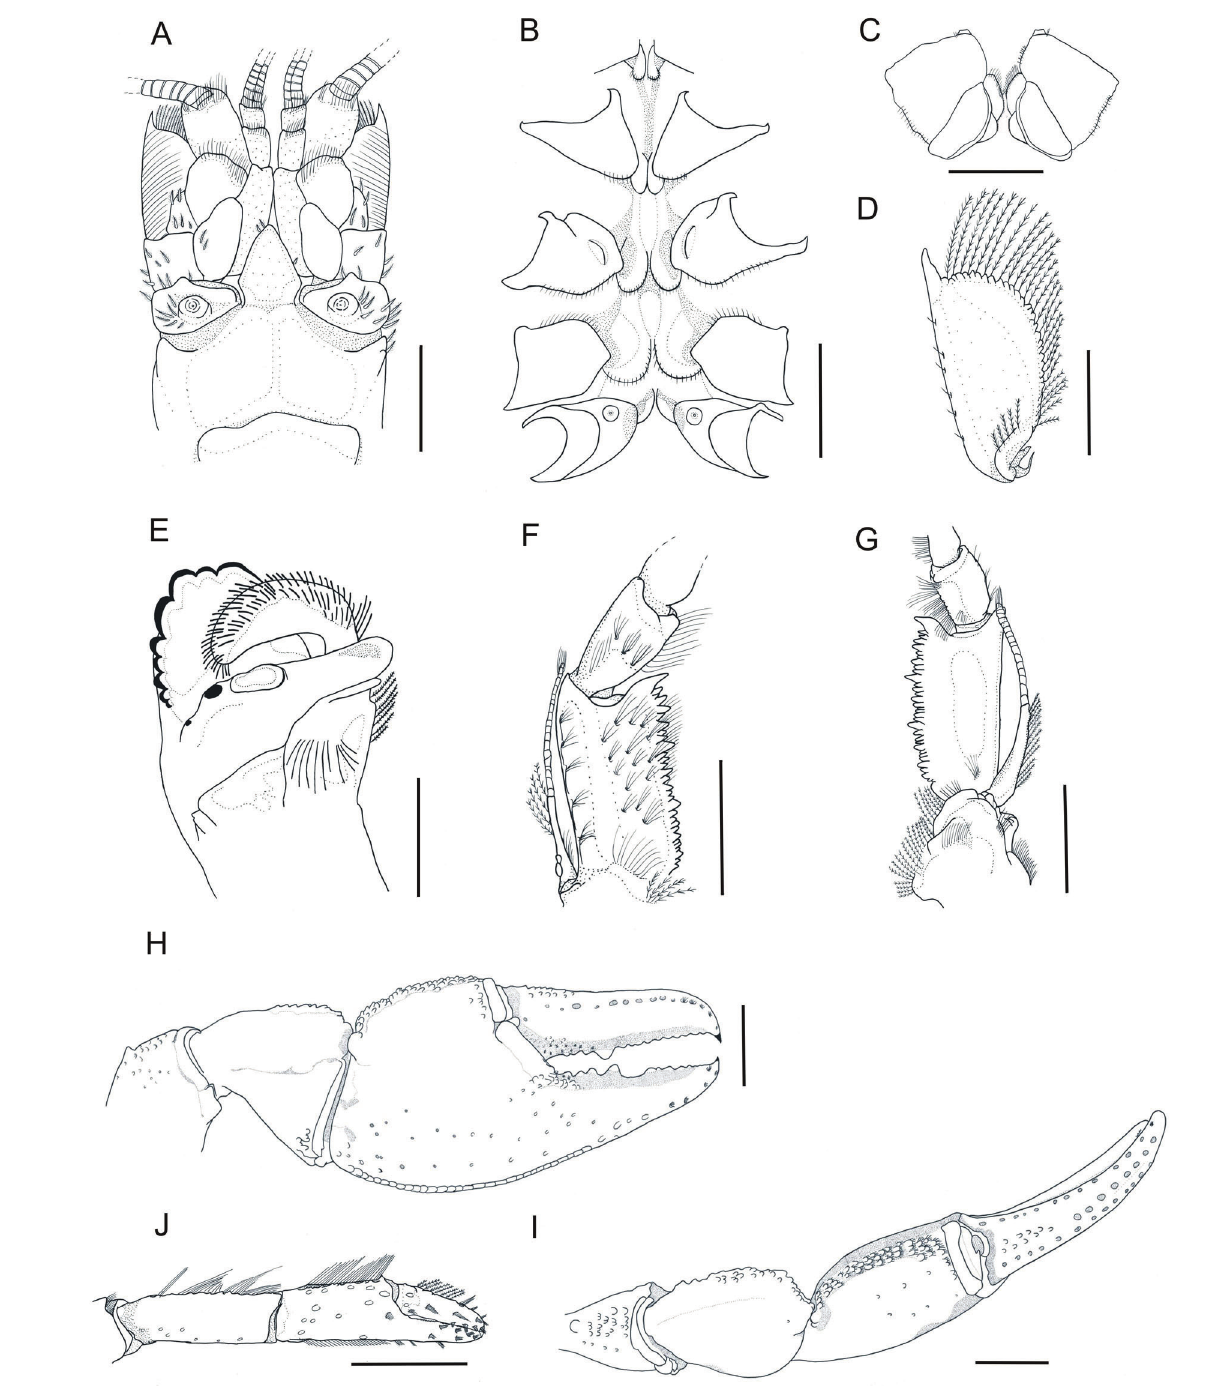
Figure 2. Parastacus tuerkayi sp. nov., holotype (MZUSP 34940) and paratypes (UFRGS 3167, UFRGS 6438). A, epistome (holotype); B, thoracic sternites and gonopores (holotype); C, thoracomere 8, caudal view (holotype); D, antennal scale, lateral view (UFRGS 3167); E, mandible (UFRGS 6438); F, third maxilliped, ventral view (UFRGS 6438); G, third maxilliped, dorsal view (UFRGS 6438); H, first pereiopod, lateral view (holotype); I, first pereiopod, dorsal view (holotype); J, second pereiopod, lateral view (holotype). Scale bars: A = 3.3 mm; B, C, H, I, J = 5 mm; D, E = 1.6 mm; F, G = 3.33